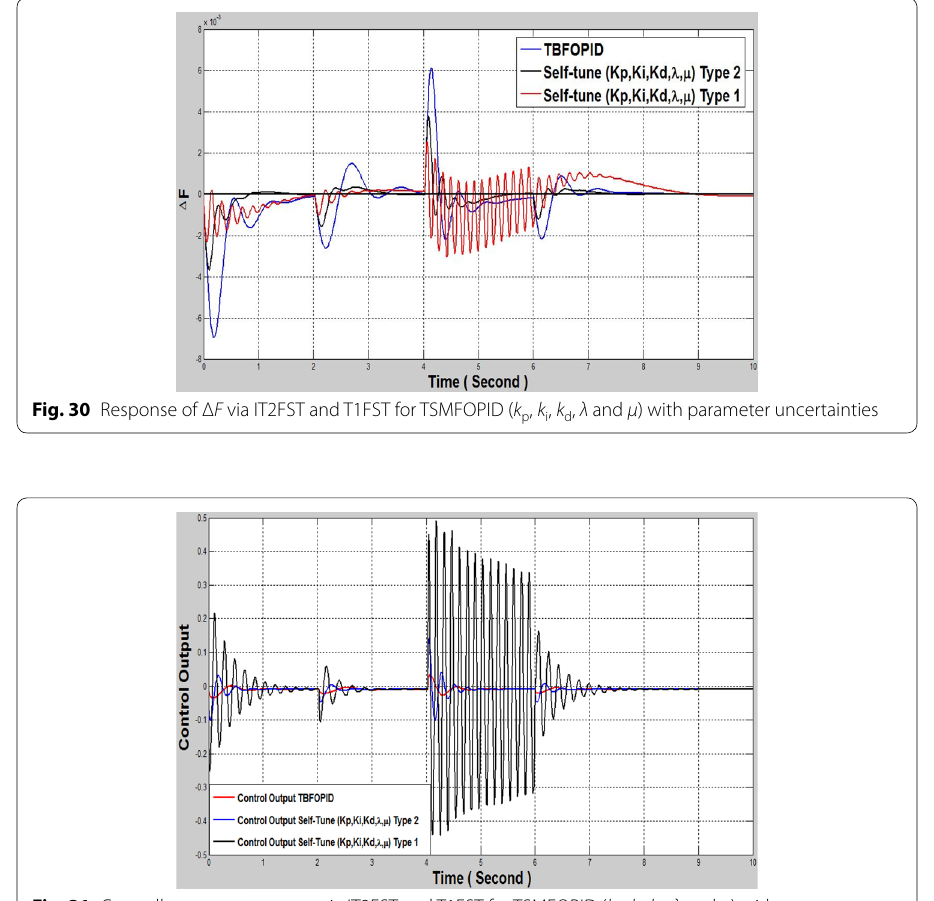
Fig. 31 Controller output response via IT2FST and T1FST for TSMFOPID ( k p , k i , k d , λ and μ ) with parameter